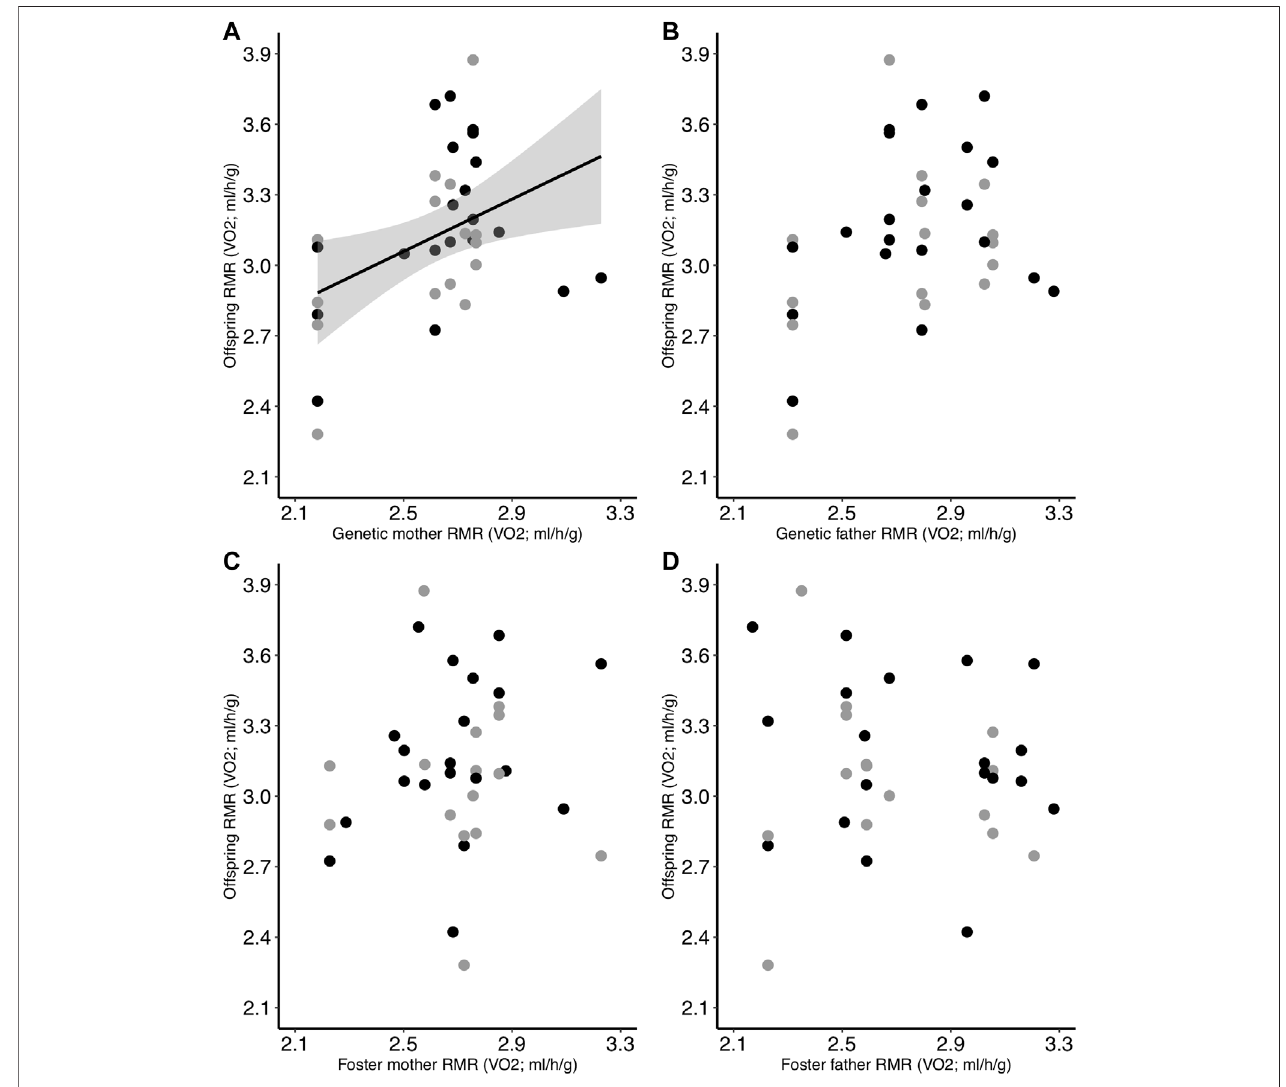
FIGURE 4 | Relationship between offspring RMR on Day 30 and the RMR of the (A) genetic mother, (B) genetic father, (C) foster mother, and (D) foster father. Offspring had been incubated at two different temperatures as eggs (black = control; gray = low). Regression lines are included only for signi fi cant relationships.